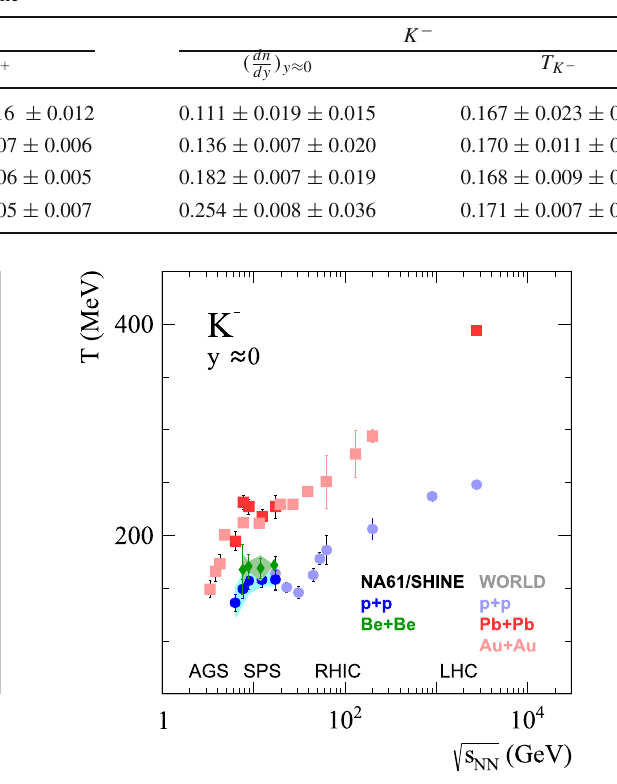
Fig. 29 The energy dependence of the inverse slope parameter of p T spectraatmid-rapidityofpositively(left)andnegatively(right)charged K mesons for central Be+Be, Pb+Pb and Au+Au collisions as well as